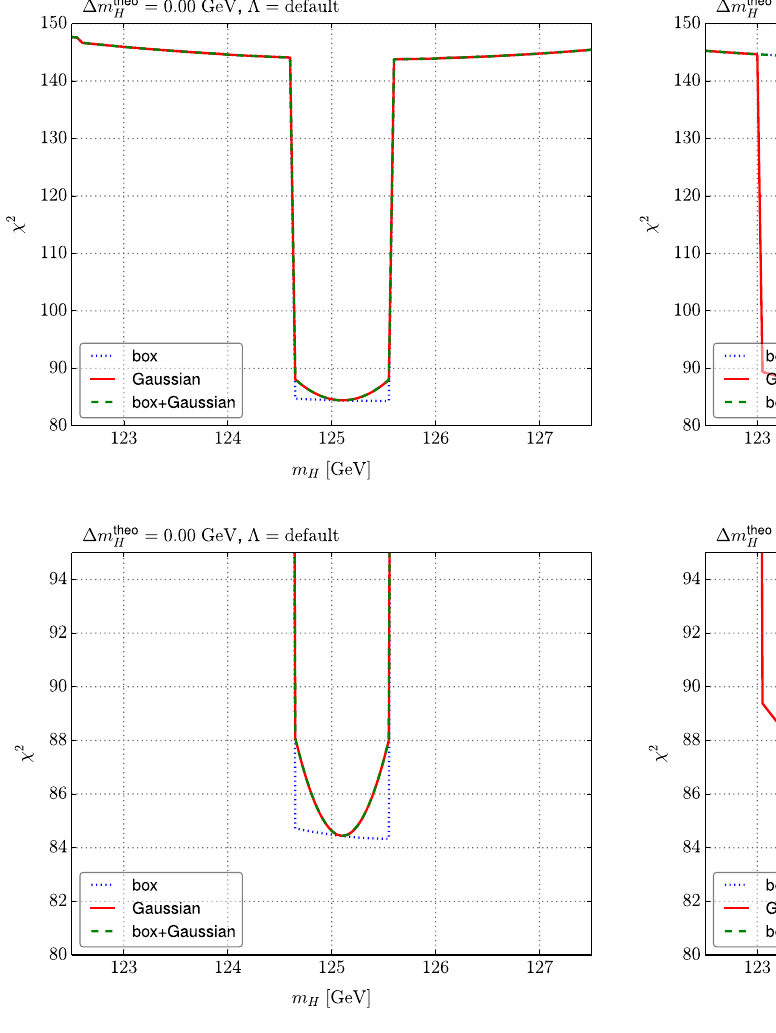
Fig. 1 Total χ 2 as a function of the Higgs mass, m H , for the case of no theoretical mass uncertainty (left panels) and a theoretical mass uncertainty of 1 GeV (right panels). The Higgs couplings are set to the SM prediction, and the assignment range parameters ( (cid:14),(cid:14) m ) are set to